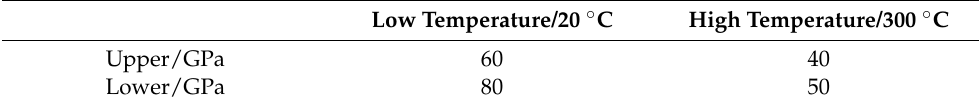
Table 11. The range of elastic modulus with temperature-dependent.